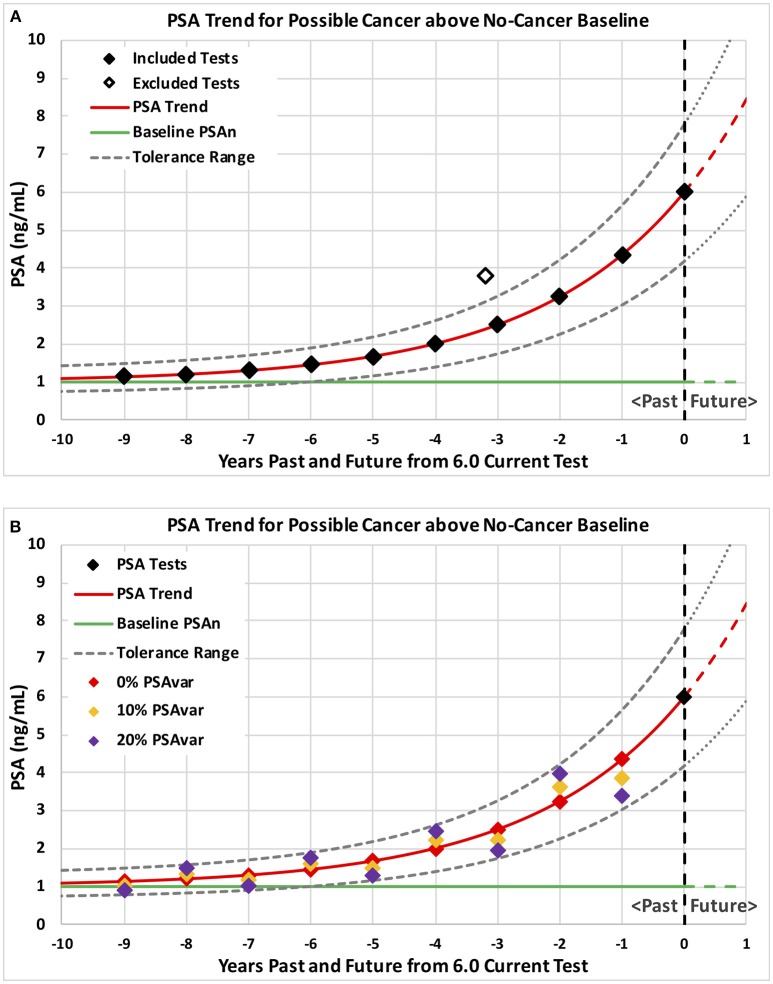
Example PSA tests and corresponding PSA trends for possible cancer above a no-cancer baseline. Example patterns of PSA tests are plotted with levels on the vertical axis and years past through current on the horizontal axis. Consistent PSA trends are shown in red above a no-cancer baseline shown in green with a tolerance range shown by dashed curves. Ten annual tests with no variation from trend plus a possible excluded high PSA test are shown on graph (A) followed by three sets of ten annual tests shown on graph (B) with 0% (red), 10% (orange), and 20% (purple) test variability around the trend (PSAvar).